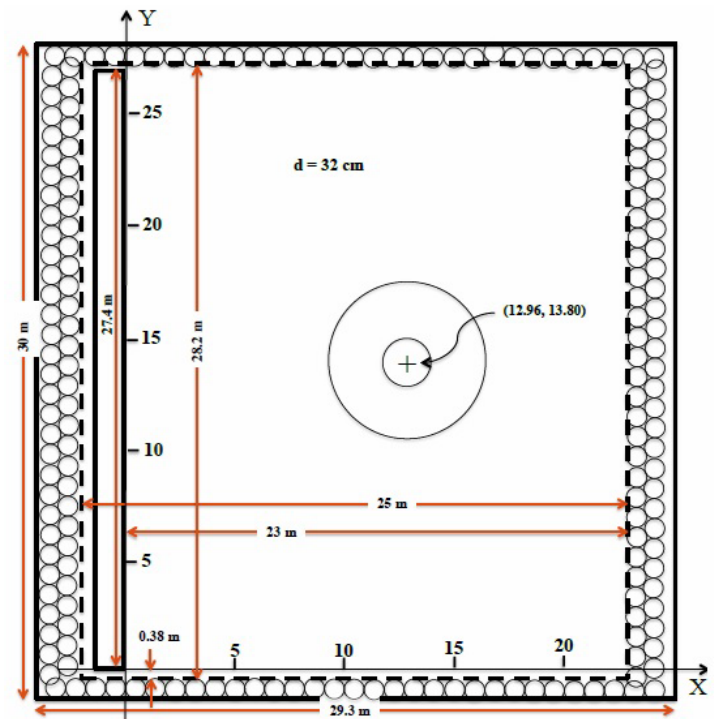
Figure A5. Basin geometry and coordinate system. Solid lines represent approximate basin and wavemaker surfaces. Circles along walls and dashed lines represent wave-absorbing